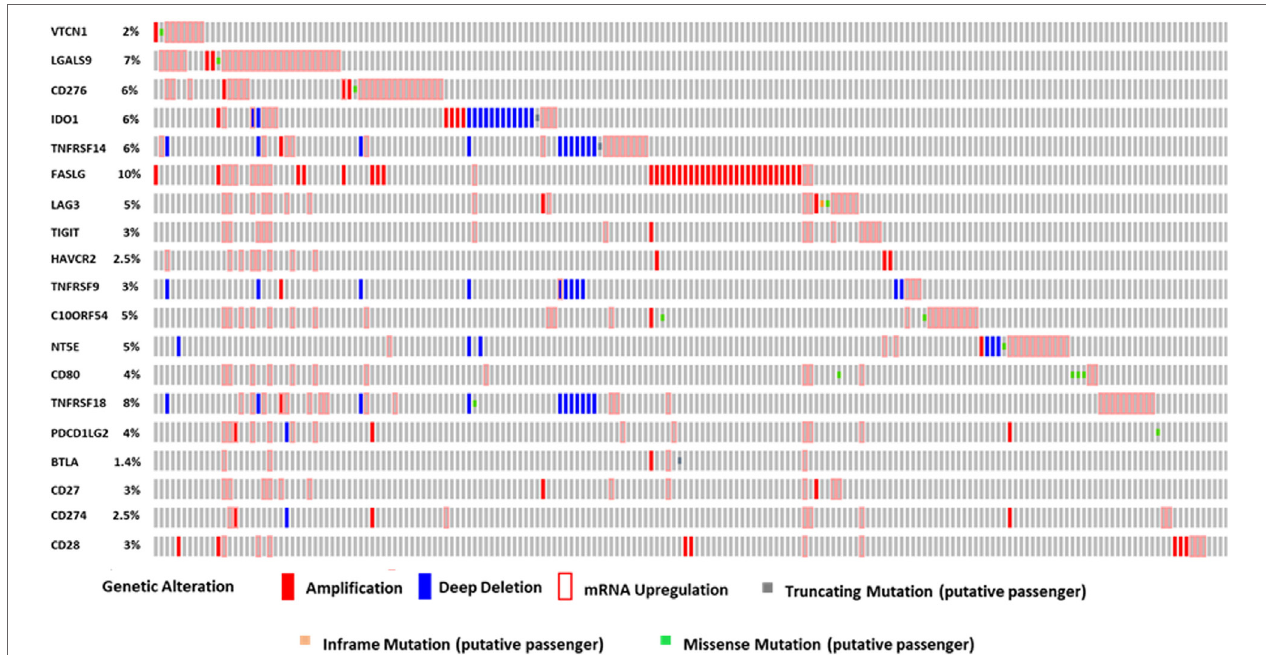
FigUre 1 | The OncoPrint from a query for alterations in expression of immune modulator genes in HCC patients. Rows and columns represents genes and patients, respectively. Genomic alterations, including CNAs (homozygous deletions and amplifications), mutations, and variation in gene or protein expression are summarized by glyphs and color coding. The cases are sorted as per alterations.